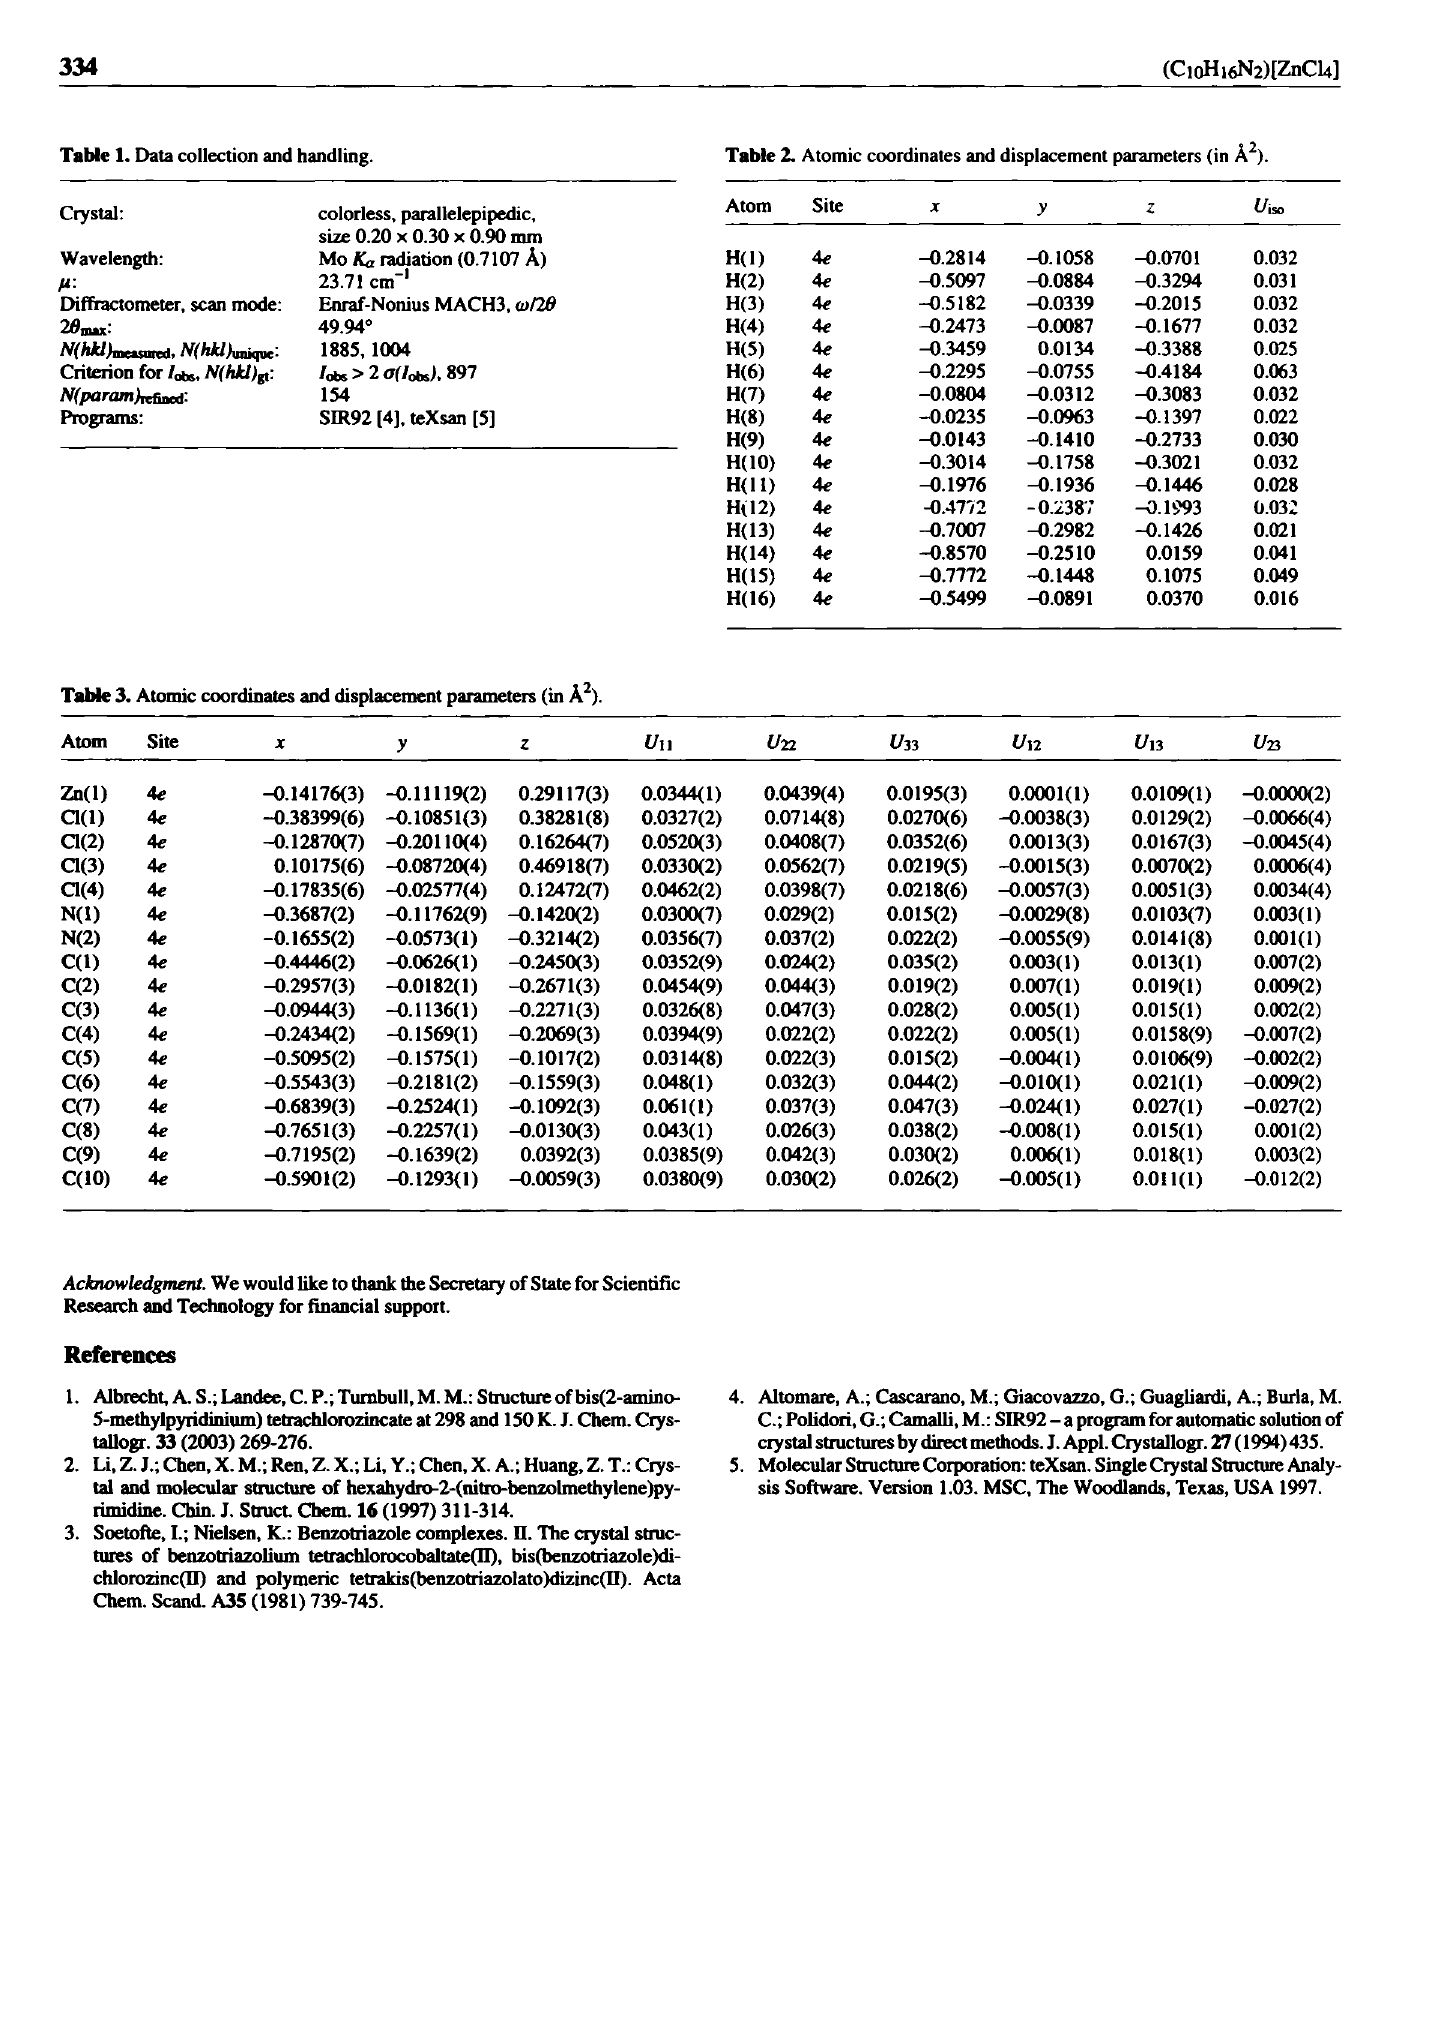
Table 1. Data collection and handling. Table 2. Atomic coordinates and displacement parameters (in Ä 2 ).